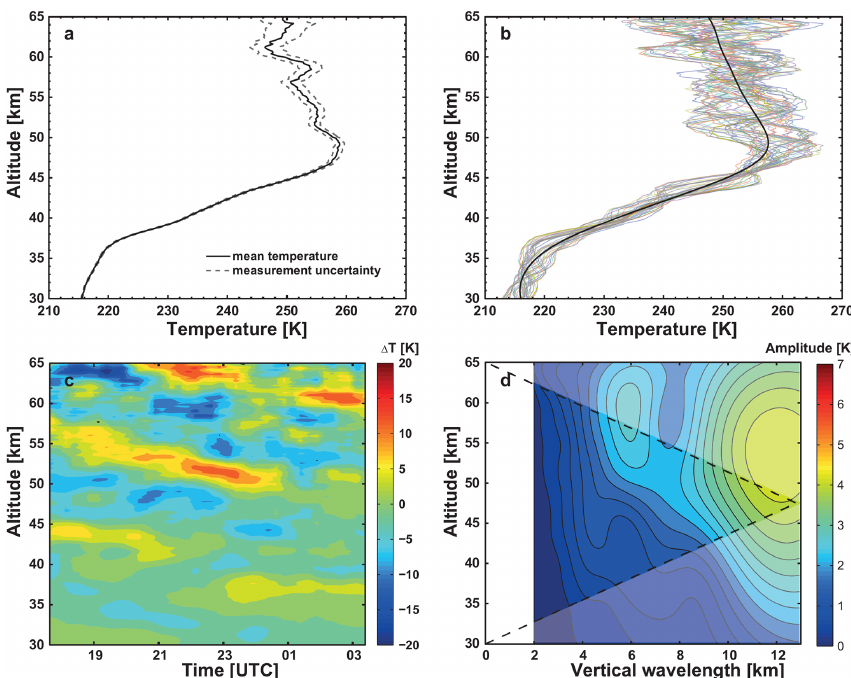
Figure 1. (a) Temperature profile (black) and uncertainty (dashed) as derived from a lidar measurement on 6 March 1998 between 17:30 and 03:30UT. (b) Temperature profile averaged over the entire measurement period after applying a moving spline fit (black line) and individual one hour mean profiles derived by moving the averaging window in step of 15 minutes (colored lines). (c) Hofmüller diagram of the temperature perturbations during the measurement period. (d) Mean wavelet spectrum with the amplitudes color-coded as a function of vertical wavelength and altitude. The gray shaded area marks results that are influenced by edge effects (cone of